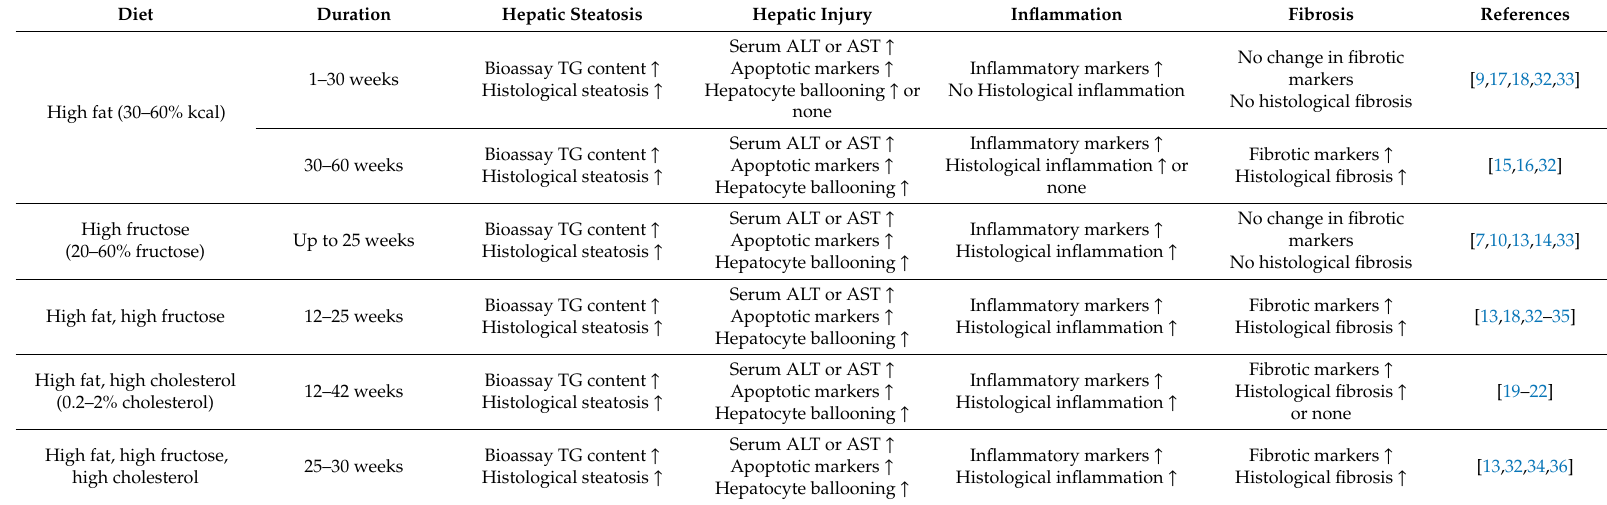
Table 1. Overview of high fat / high carbohydrate consumption-induced characteristics of nonalcoholic fatty liver disease (NAFLD) in animal